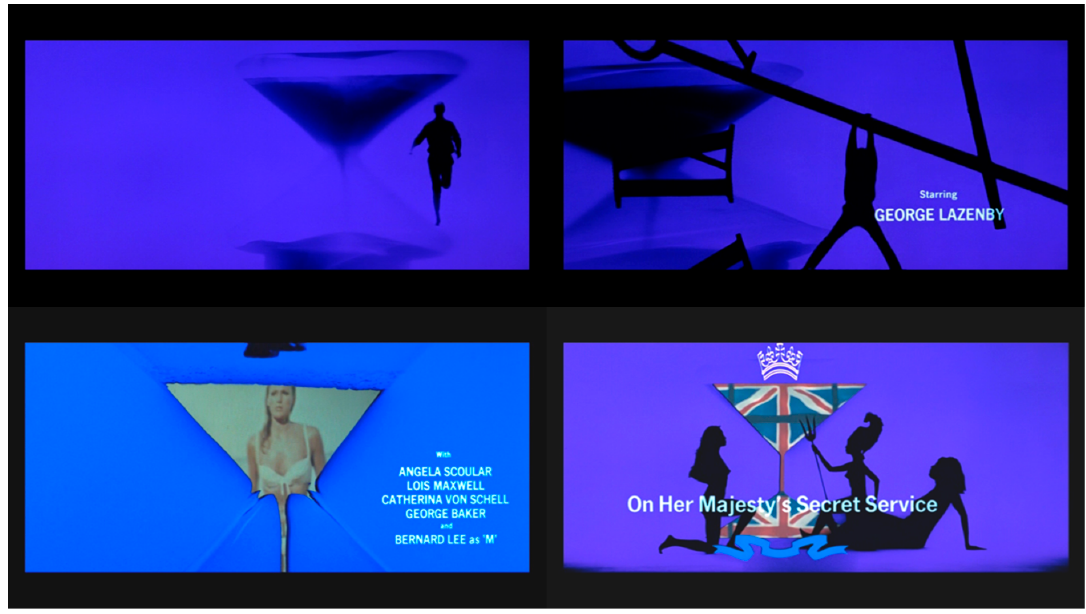
Figure 2. The sands of time and the spirit of ‘Rule, Britannia!’ ( On Her Majesty’s Secret Service